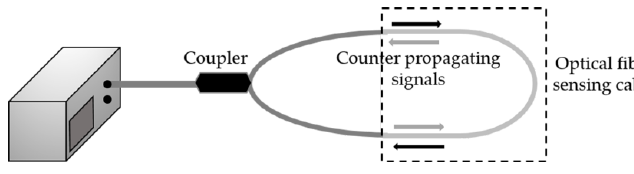
Figure 19. Schematic diagram of a SI experimental setup.